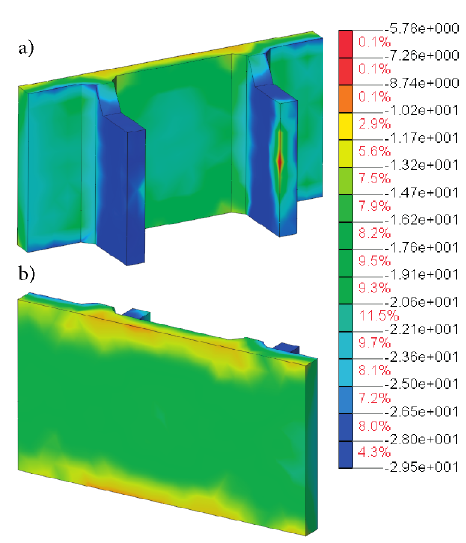
Fig. 11. Distribution of compressive stresses of concrete blocks within the P6-30 masonry fragment